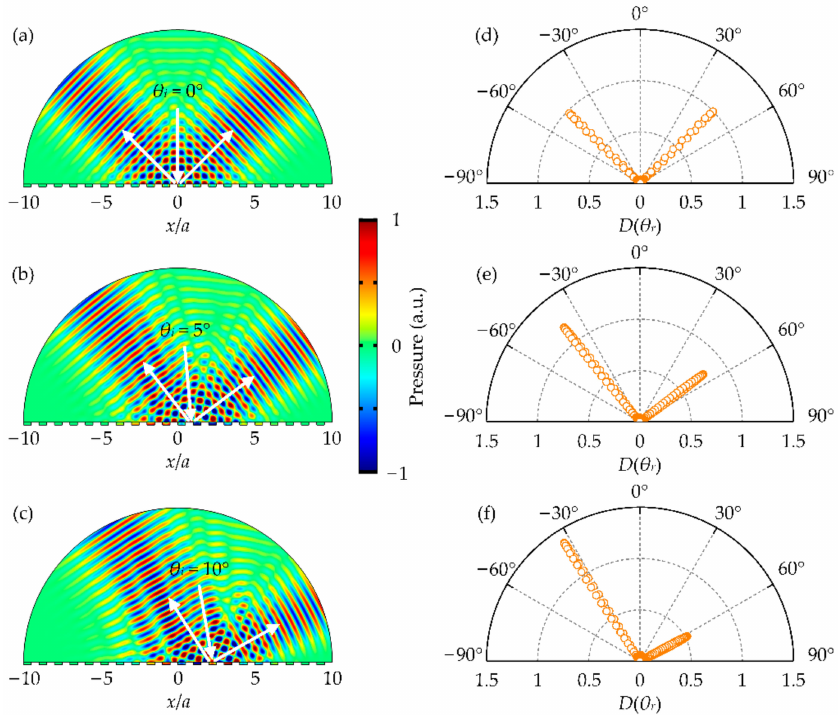
Figure 4. The case of a = 1.4 λ 0 . The scattering pressure field distributions for the beam splitting with the incident angle of ( a ) θ i = 0 ◦ , ( b ) θ i = 5 ◦ , and ( c ) θ i = 10 ◦ . The white arrows show the directions of the incident and the reflected waves. The polar plots of the normalized intensity of the scattering waves in the exterior field with the incident angle of ( d ) θ i = 0 ◦ , ( e ) θ i = 5 ◦ , and ( f ) θ i = 10 ◦ . The ) . All the intensities are normalized lateral axes in ( d – f ) are the normalized intensity defined as D ( θ r to the maximal intensity of the scattering waves of the normal